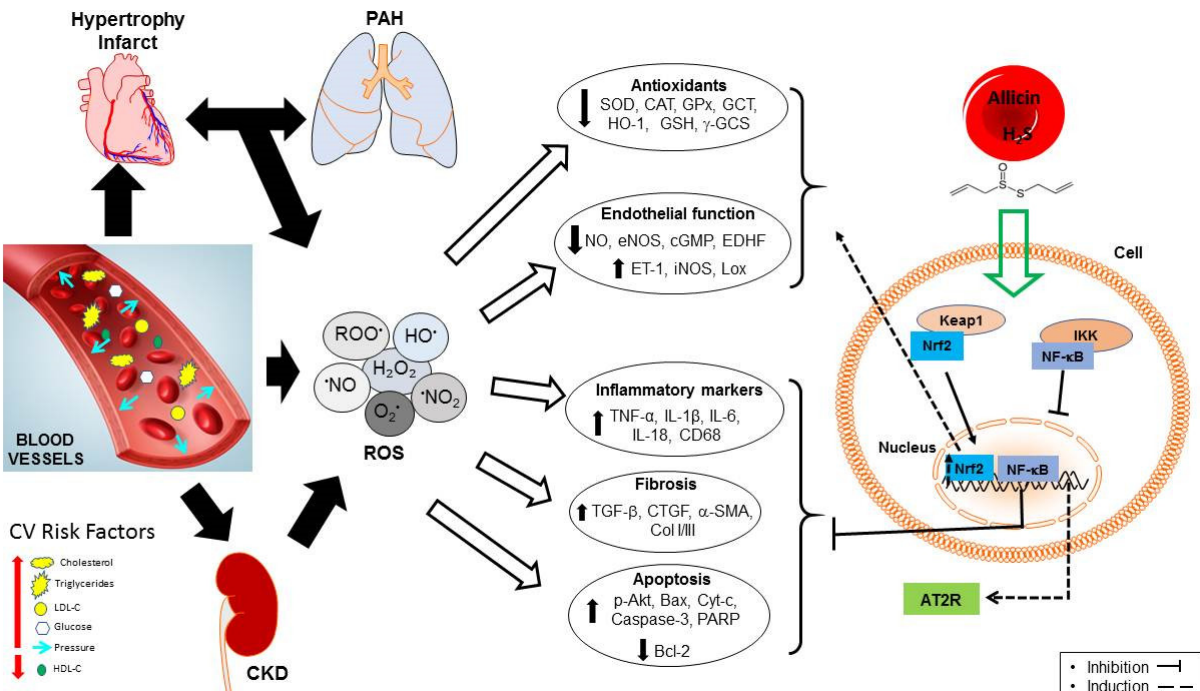
Figure 4. Allicin, through the stimulation of transcription factors, counteracts the deleterious effects of the imbalance between the formation and elimination of ROS in cardiovascular diseases. Abbreviations: angiotensin II receptor type 2 (AT2R); BCL2 associated apoptosis regulator (Bax); B-cell lymphoma 2 (Bcl-2); catalase (CAT); collagen I/III (Col I/III); connective tissue growth factor (CTGF); chronic kidney disease (CKD); cytochrome C (Cyt-c); cyclic guanosine monophosphate (cGMP); endothelin-1 (ET-1); endothelium-derived hyperpolarizing factor (EDFH); endothelial nitric oxide synthase (eNOS); glutathione peroxidase (GPx); γ -glutamyl cysteine synthase ( γ -GCS); nuclear factor erythroid 2–related factor 2(Nrf2); heme oxygenase-1 (HO-1); high-density lipoprotein-cholesterol (HDL-C); hydrogen sulfide (H 2 S); endothelial nitric oxide synthase (eNOS); inducible nitric oxide synthase (iNOS); interleukin 1 beta (IL-1 β ); interleukin 6 (IL-6); interleukin 18 (IL-18); low-density lipoprotein-cholesterol (LDL-C); nitric oxide (NO); nuclear factor kappa B (NF- κ B); oxidized lipids (Lox); poly(ADP-ribose) polymerase (PARP); pulmonary arterial hypertension (PAH); reactive oxygen species (ROS); reduced glutathione (GSH); superoxide dismutase (SOD); alpha-smooth muscle actin ( α -SMA); transforming growth factor beta (TGF- β ); tumor necrosis factor-alpha (TNF- α